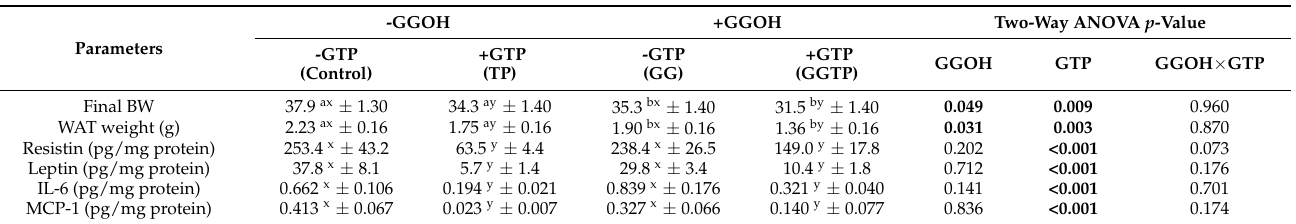
Table 3. Effects of GGOH and GTP supplementation on final body weights, white adipose tissue weights and adipokine